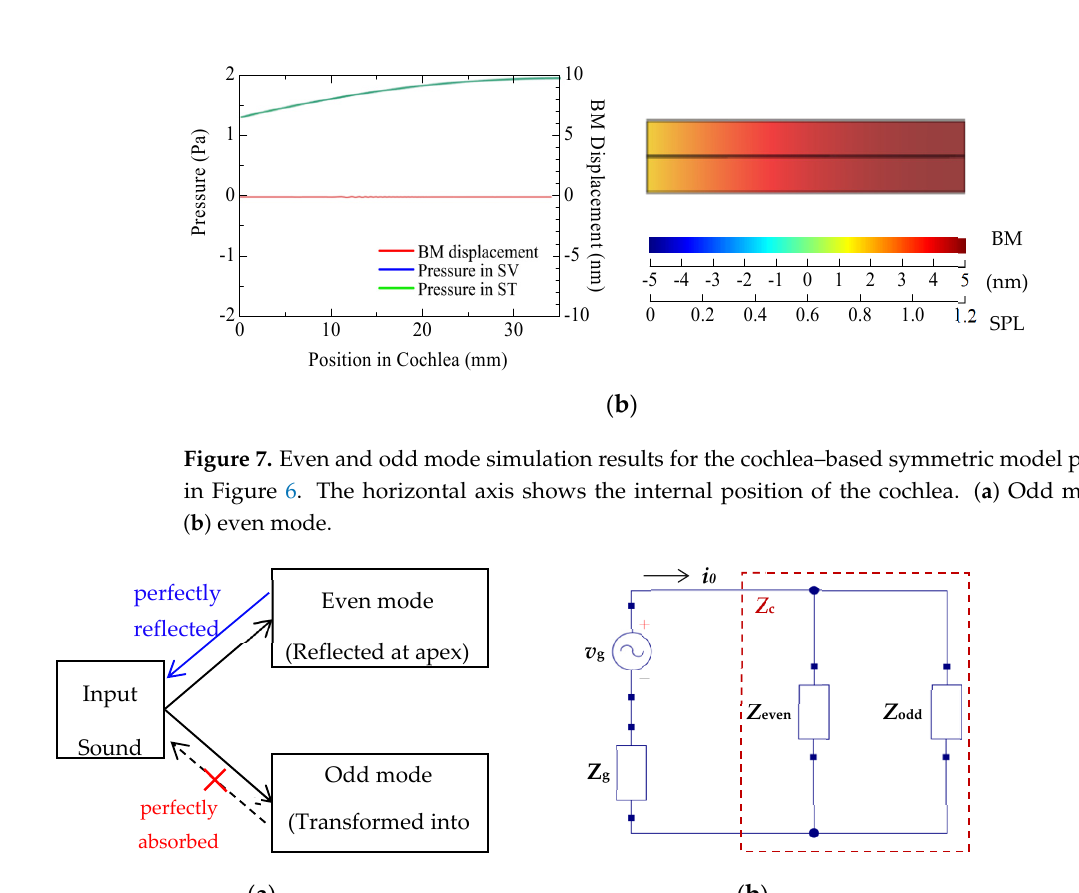
Figure 7. Even and odd mode simulation results for the cochlea–based symmetric model presented in Figure 6. The horizontal axis shows the internal position of the cochlea. ( a ) Odd mode and ( b ) even mode.